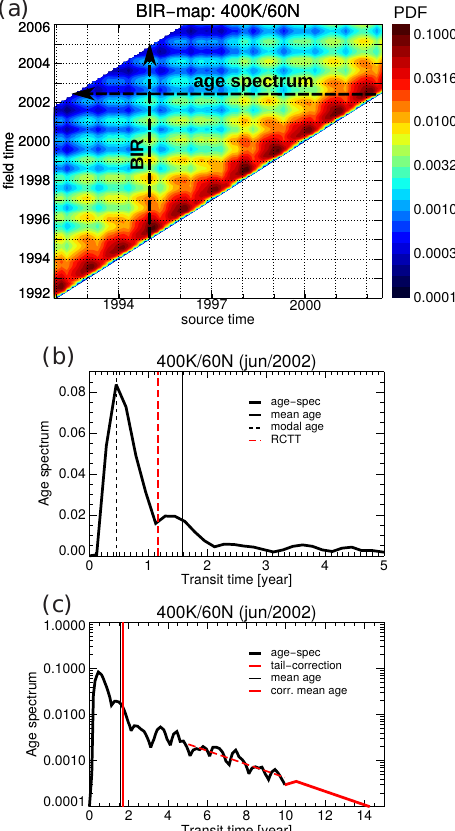
Figure 3. (a) BIR map from CLaMS pulse tracers at 400K and 60 ◦ N, plotted only for part of the full simulation period. Arrows highlight vertical and horizontal cuts through the BIR map repre- senting BIR (vertical) and age spectrum (horizontal), respectively (cf. Haine et al., 2008). (b) The age spectrum for June 2002, cor- responding to the horizontal cut in (a) . Vertical lines show mean age (solid), modal age (black dashed), and the residual circulation transit time (red dashed, see text). (c) Same as (b) , but including a correction for the finite spectrum tail using an exponential fit (see text). The red vertical line shows mean age for the tail-corrected spectrum, the black line for the uncorrected case (note the larger transit time range and logarithmic y